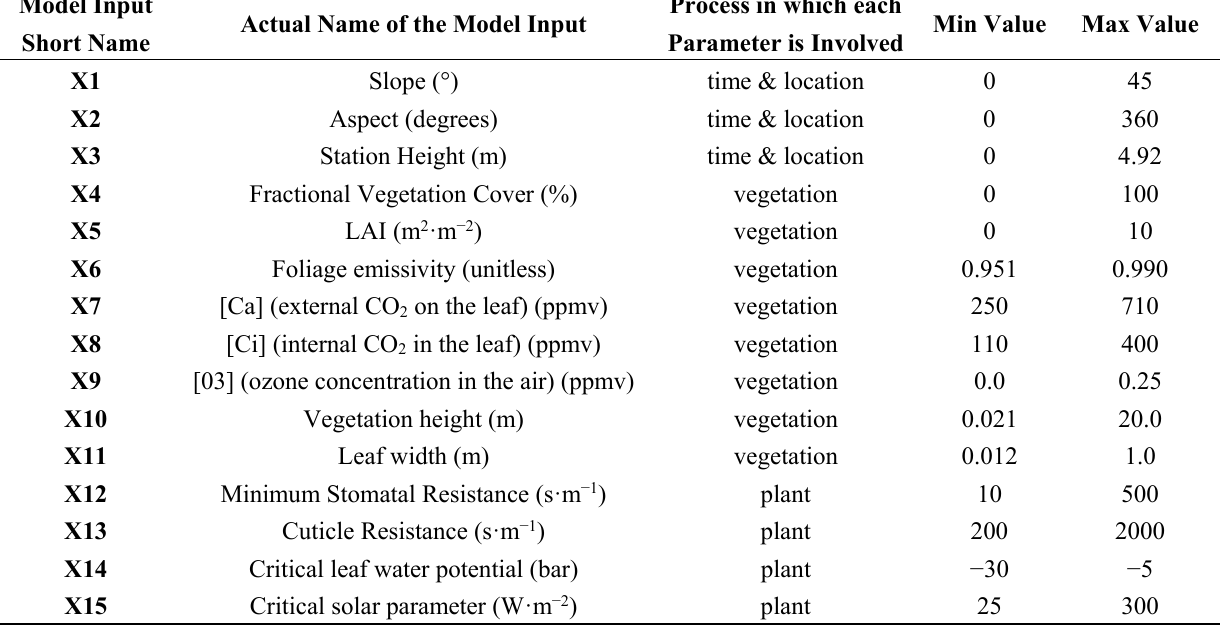
Figure 1. Overview of the SA implemented in this study. Table 2. Summary of the SimSphere inputs considered in the GSA implementation using the BACCO GEM-SA method. The units of each of the model inputs are also provided in